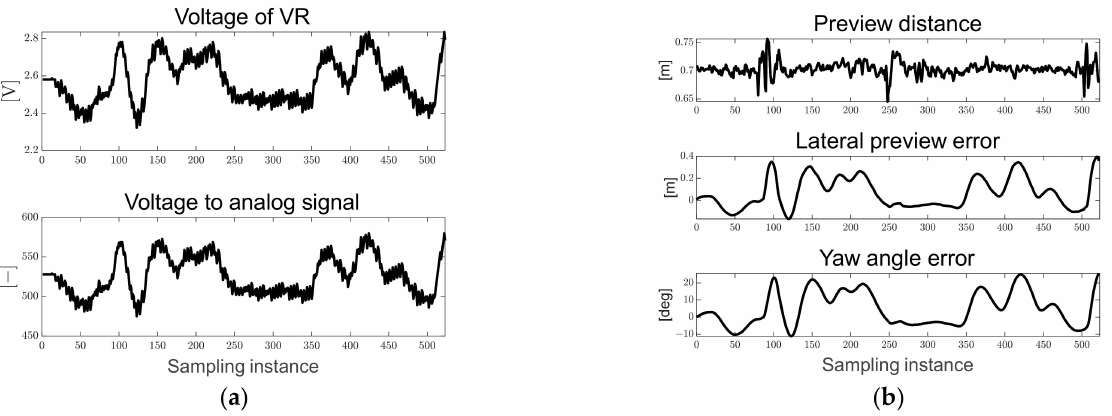
Figure 12. Ellipse path tracking scenario results; ( a ) voltage of VR and analog signal for map-based calculation; ( b ) path errors: preview distance, lateral preview and yaw angle errors.